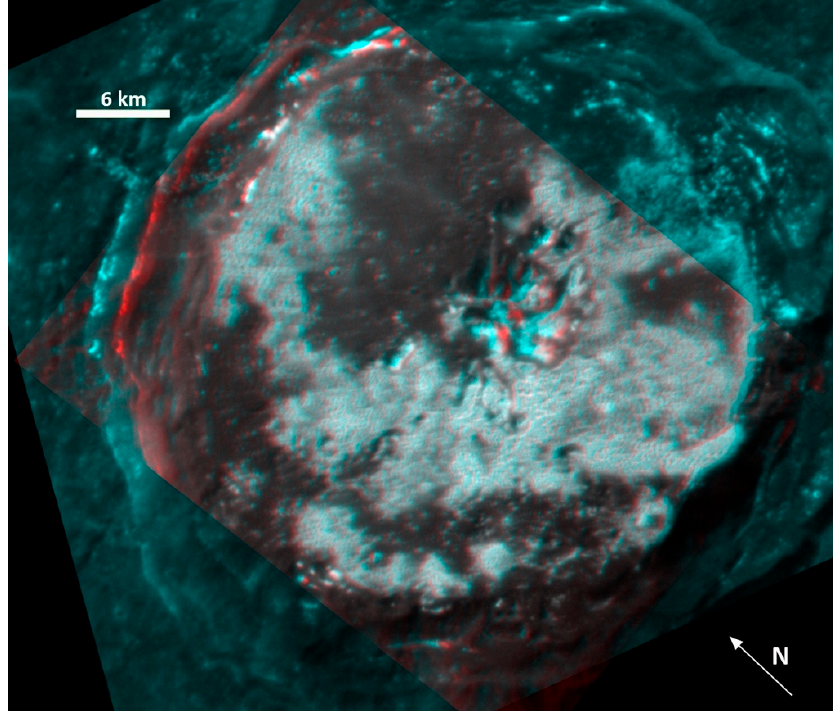
Figure A10. Kertész Crater. Images: EN1010096377M, EN1010096528M.